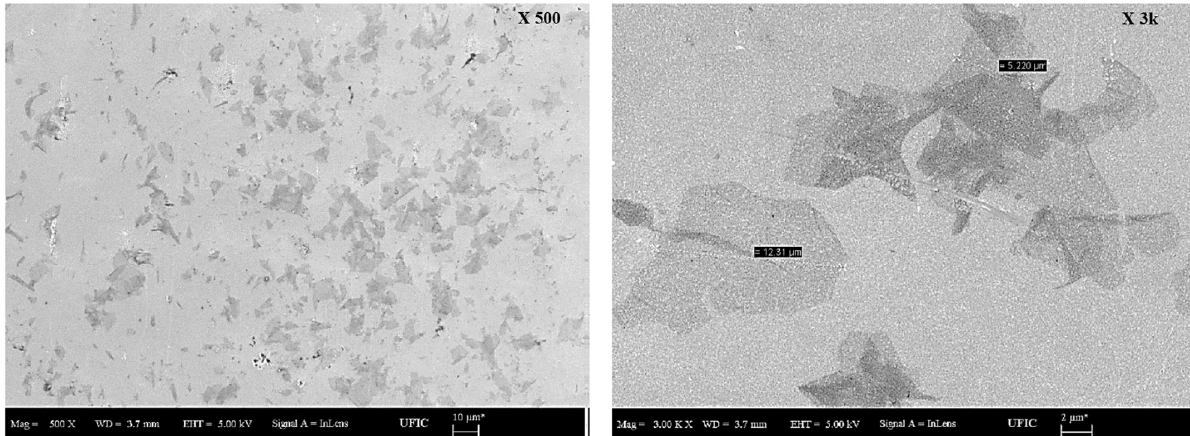
Figure 1: SEM particle size